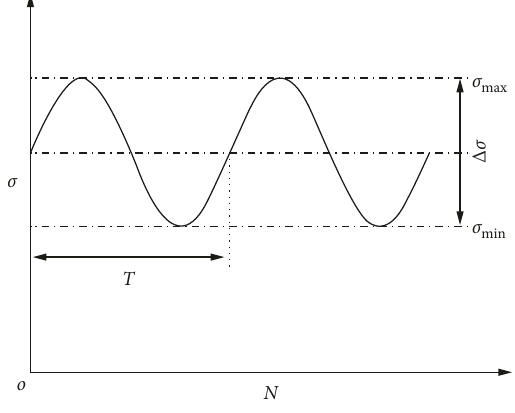
Figure 2: Sketch of wave shape of cyclic